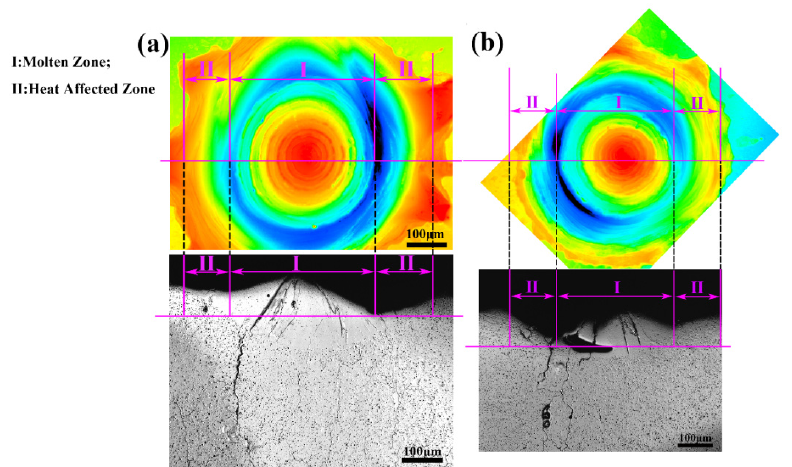
Figure 15. The 3D confocal microstructure of the thermal shock surface (RD–ND surface) and the cross-section (TD–ND surface) at the power density of 0.64 GW/m 2 : the rolled samples ( a ) and fully recrystallized samples ( b ).